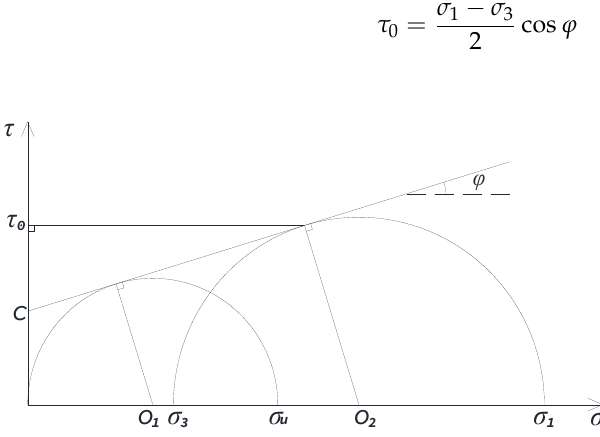
Figure 4. Schematic of the solution for c , φ , and τ 0 .